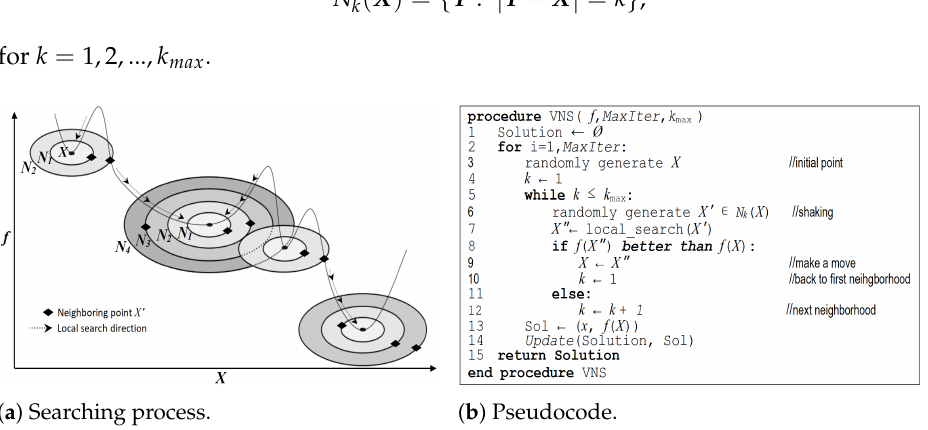
Figure 1. VNS algorithm. ( a ) The algorithm gradually expands its neighborhood structure according to k for going out from a local optimum trap [32]. ( b ) The distance of k is gradually increased by one to build a broader neighborhood